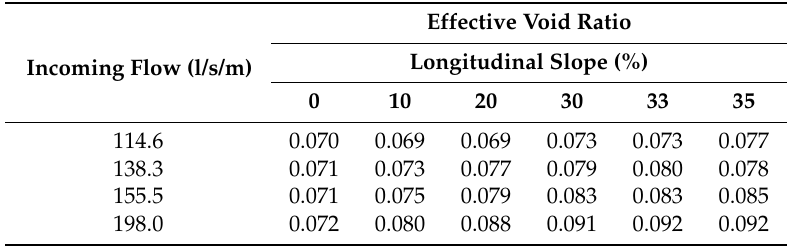
Figure 10. Effective void ratio values, m ′ , for different rack slopes and incoming flows. Table 5. Effective void ratios from Equations (1) and